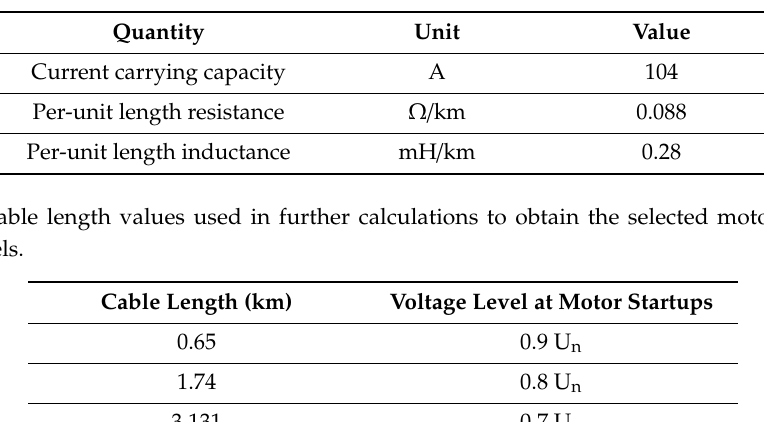
Table 4. Cable parameters.